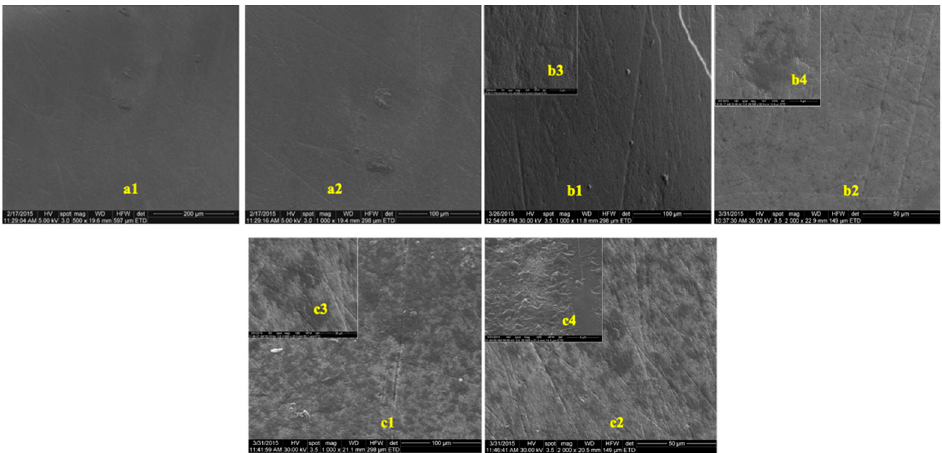
Figure 4. SEM images of enamel samples from healthy patients: ( a ) before bleaching; ( b ) after 16% whitening; ( c ) after 40% whitening. ( a1 ) Magnification—500×; ( a2 ) magnification—1000×; ( b1 ) magnification—1000×; ( b2 , c2 ) magnification—2000×; ( b3 , c1 , c4 ) magnification—20,000×; ( b4 , c4 ) magnification—40,000×; ( c3 ) magnification—30×.